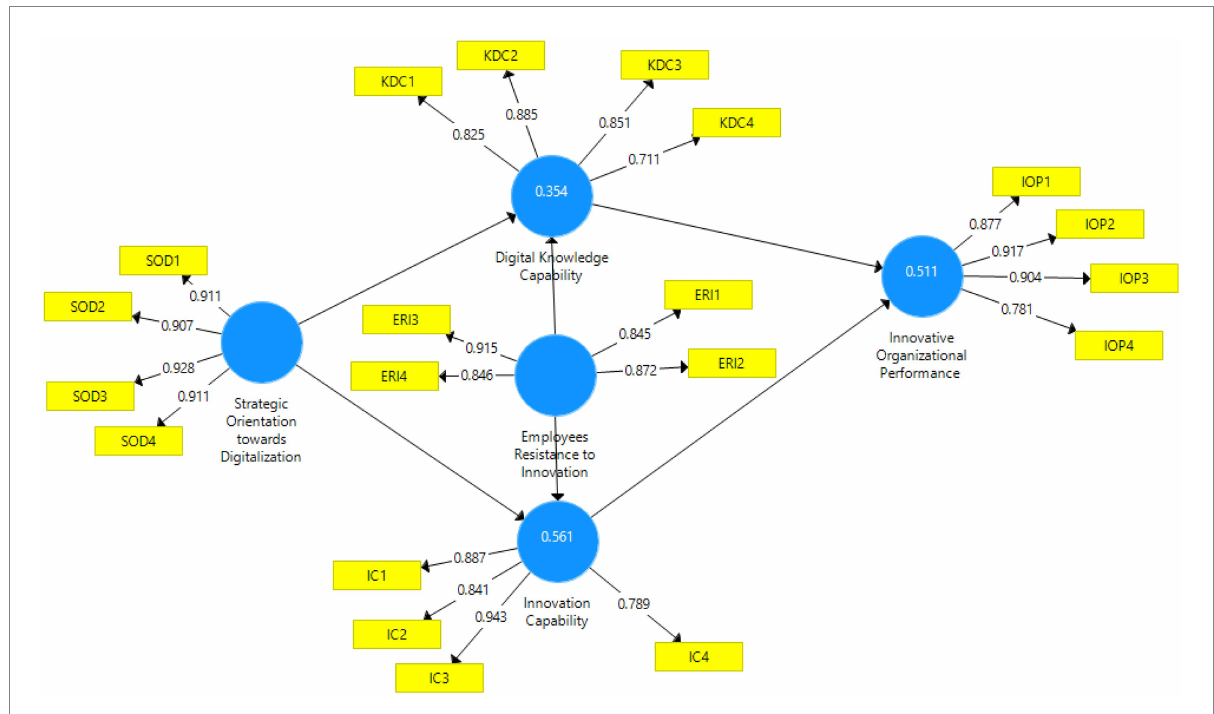
FIGURE 2 The R 2 and factor loadings of each construct in the measurement model.